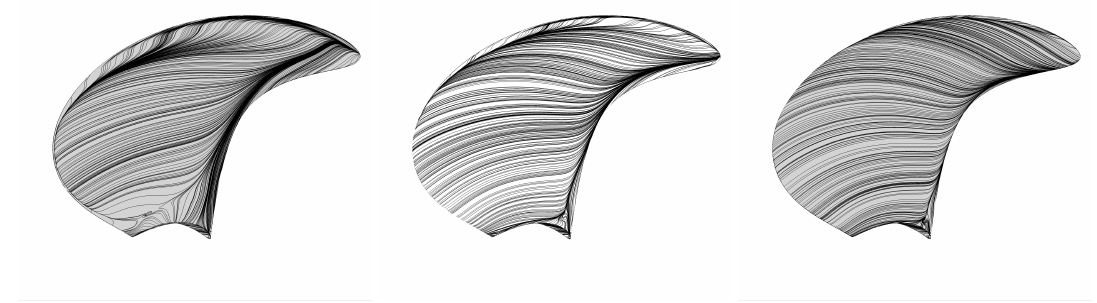
Figure 6. Limiting streamlines on propeller suction side for J = 0.37, J = 0.64 and J = 0.85. Table 7. K T and 10 K Q for rigid propeller Reynolds-averaged-Navier–Stokes and boundary element method calculations. K T (BEM) K T (RANS) 10 K Q